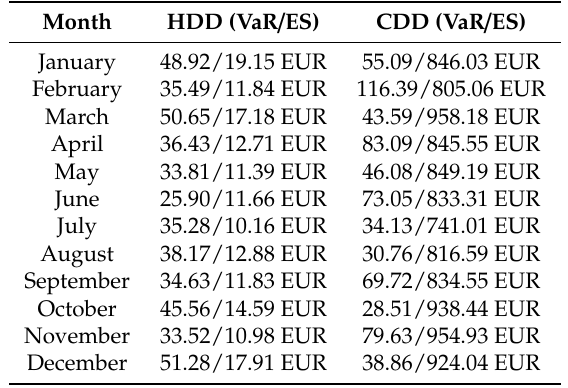
Table 3. Pure financial derivative values for heating degree days (HDD) and CDD computed from data simulated for 2017—thresholds 5% for HDD and 95% for CDD—tick size λ = 20 EUR—tail values have not been removed.